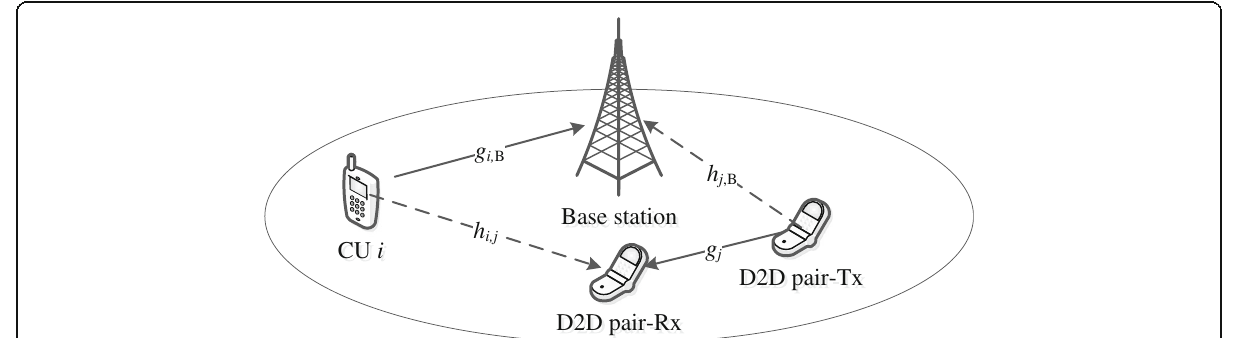
Fig. 1 System model of uplink resource reusing for some CU and D2D